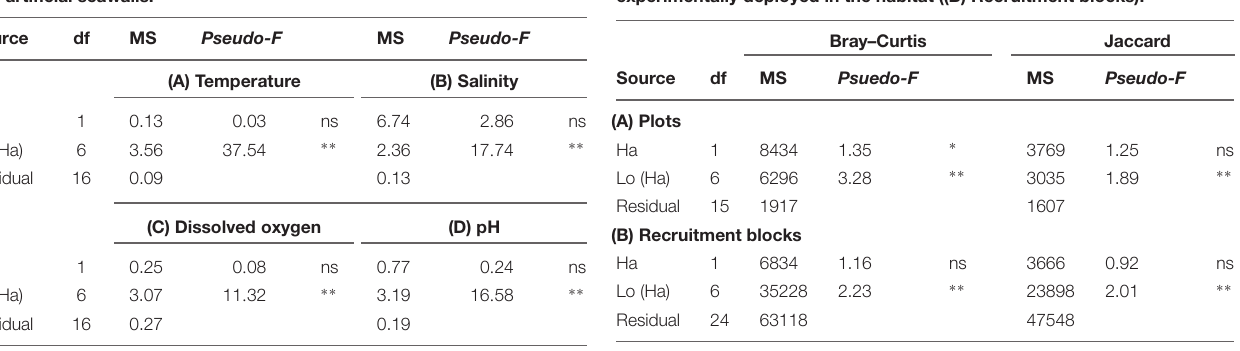
( Table 3 ). Alphaproteobacteria, Bacilli, Gammaproteobacteria,